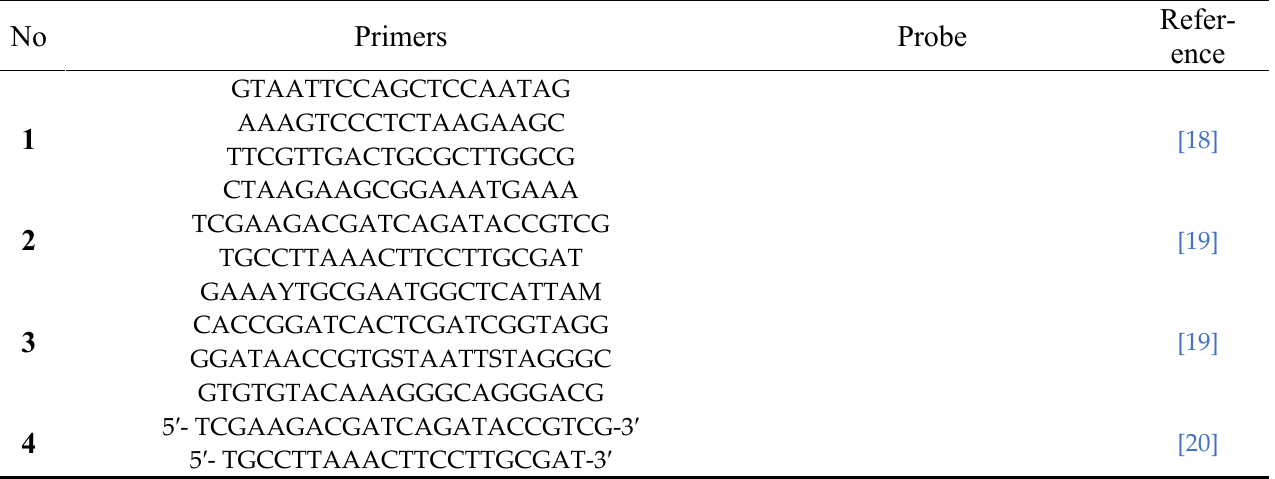
Table 1. Primers and probe used in the articles